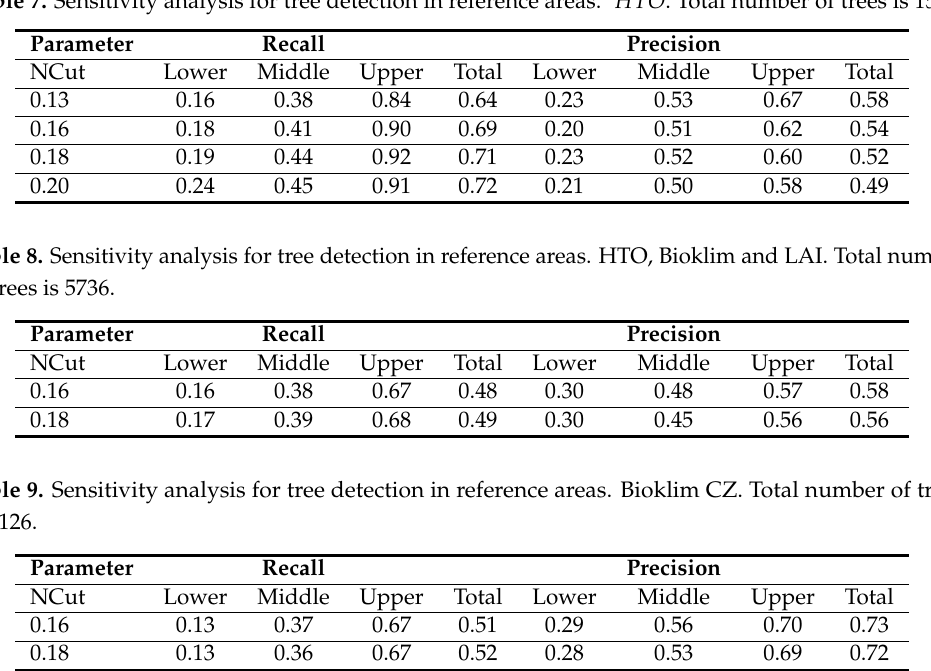
Table 10. Sensitivity analysis of tree detection regarding conifers and broadleaf trees. The reference area is HTO . Control parameter NCut max = 0.16. Total number of trees is 1596.